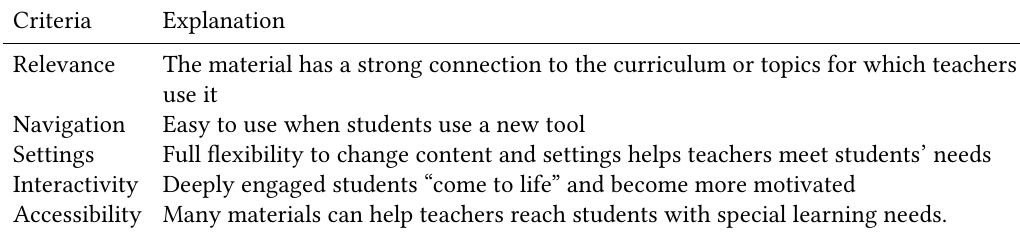
Table 4 Criteria for selecting digital